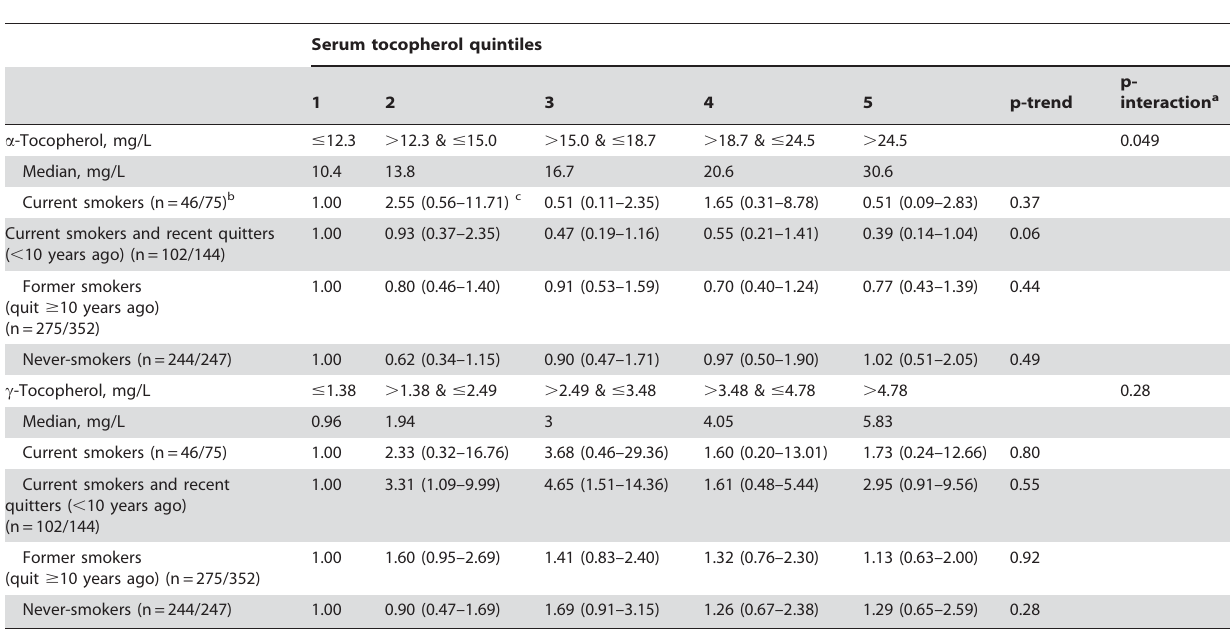
Table 5. Association between baseline serum a -tocopherol and c -tocopherol and risk of prostate cancer, stratified by smoking status, PLCO